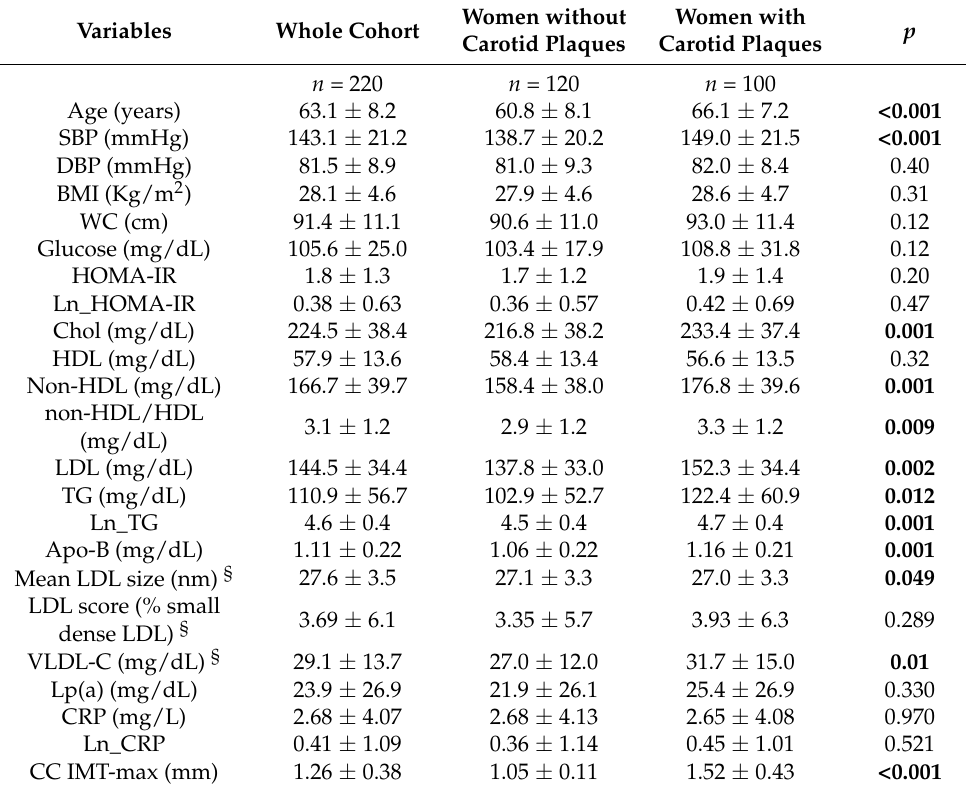
Table 1. Baseline characteristics of the population and characteristics of the groups with and without carotid plaques.